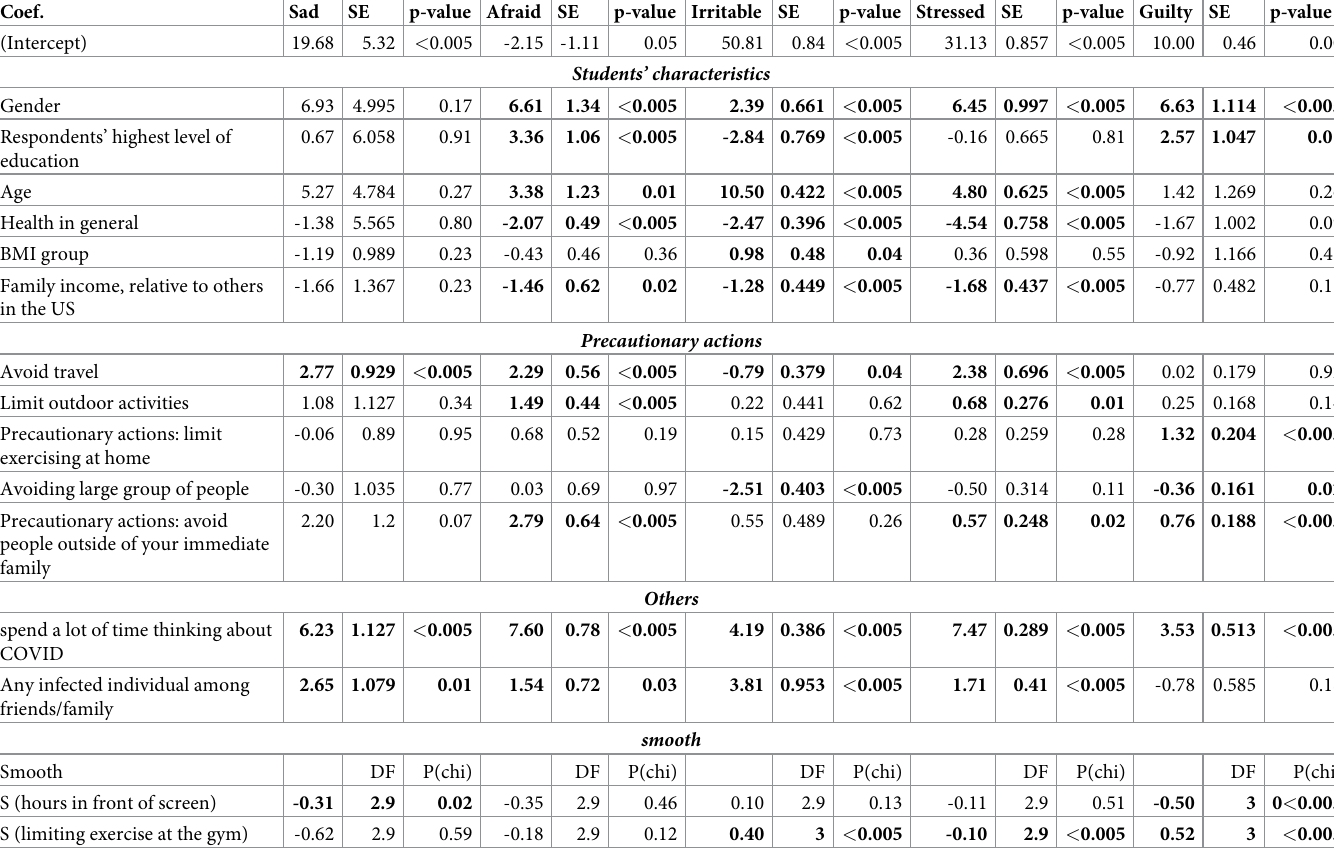
� Bolds are significant values at 0.05 significance